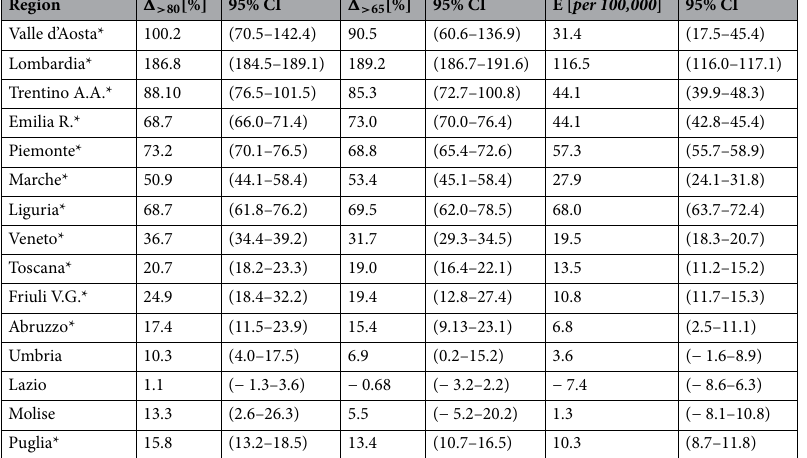
Table 2. Percentage deaths increase in the period 1st March to 15th April 2020 vs 2015–2019 for 7357 municipalities: � > 80 [ % ] for over 80s; � > 65 [ % ] for over 65 s. Corresponding 95% CI is reported. Value of E are reported per 100,000 with the corresponding 95% CI. Complete data analysis regarding stationarity and statistical significance can be read in the section “Supplementary Materials”. *Statistical significance for t-test/ Wilcoxon Signed Rank